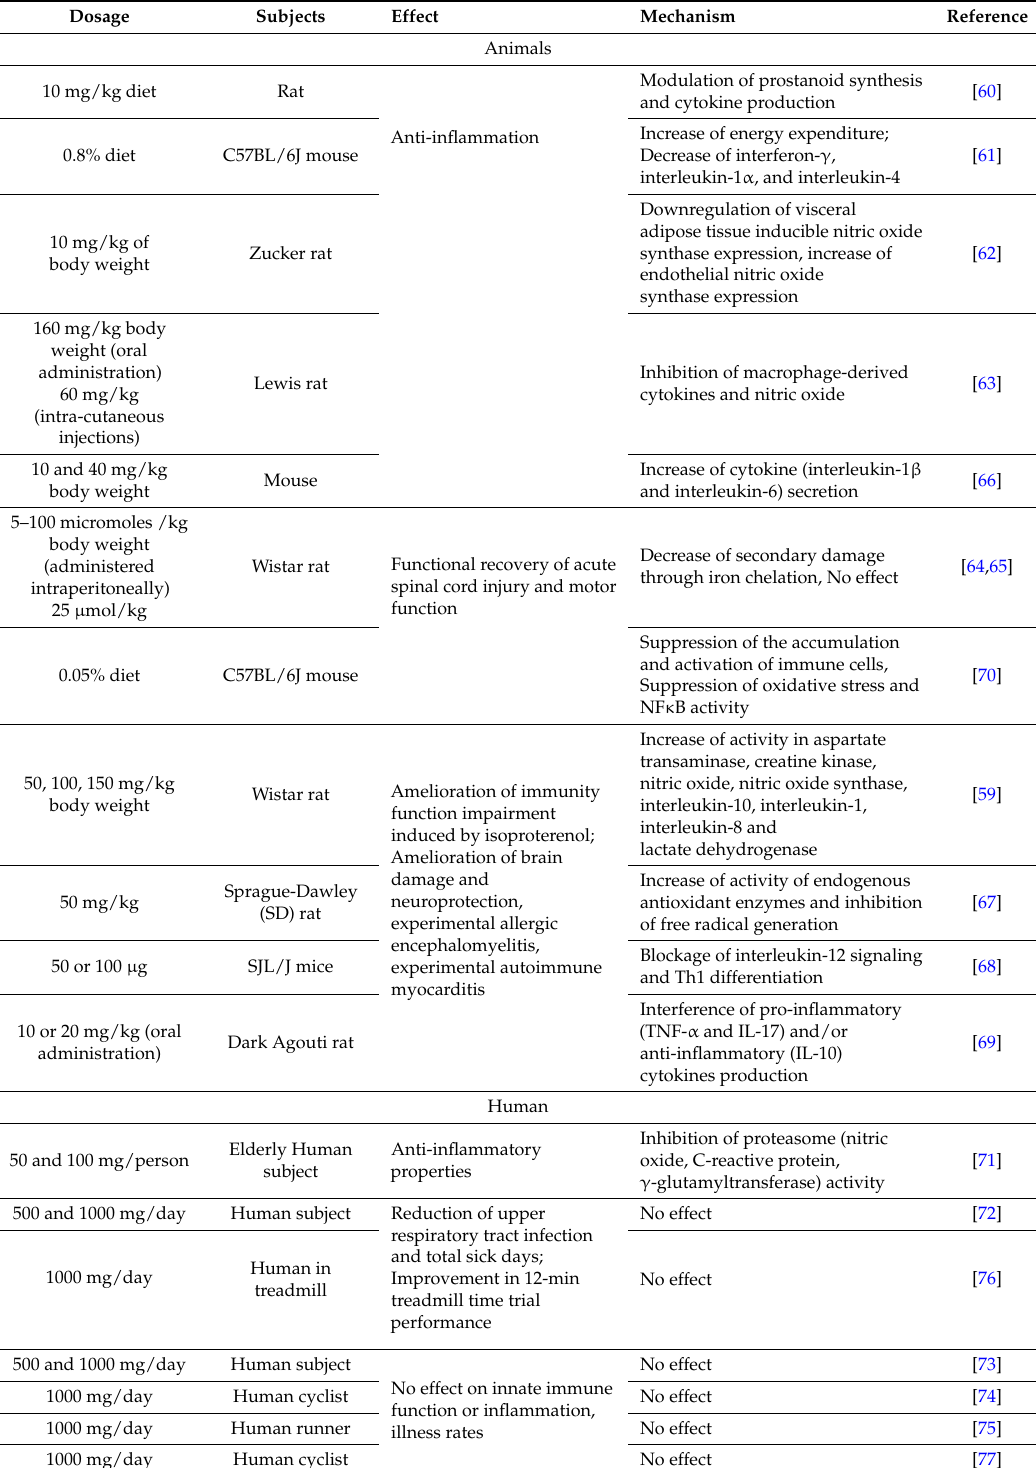
Table 2. Summary of the main effects of quercetin on inflammation and immune function in vivo